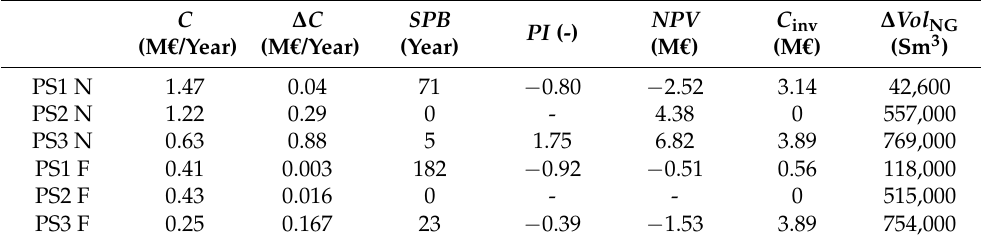
Table 11. Annual economic results of the proposed systems for the districts located in Naples and Fayoum. ∆ C C (M € /Year) PS1 N PS3 N